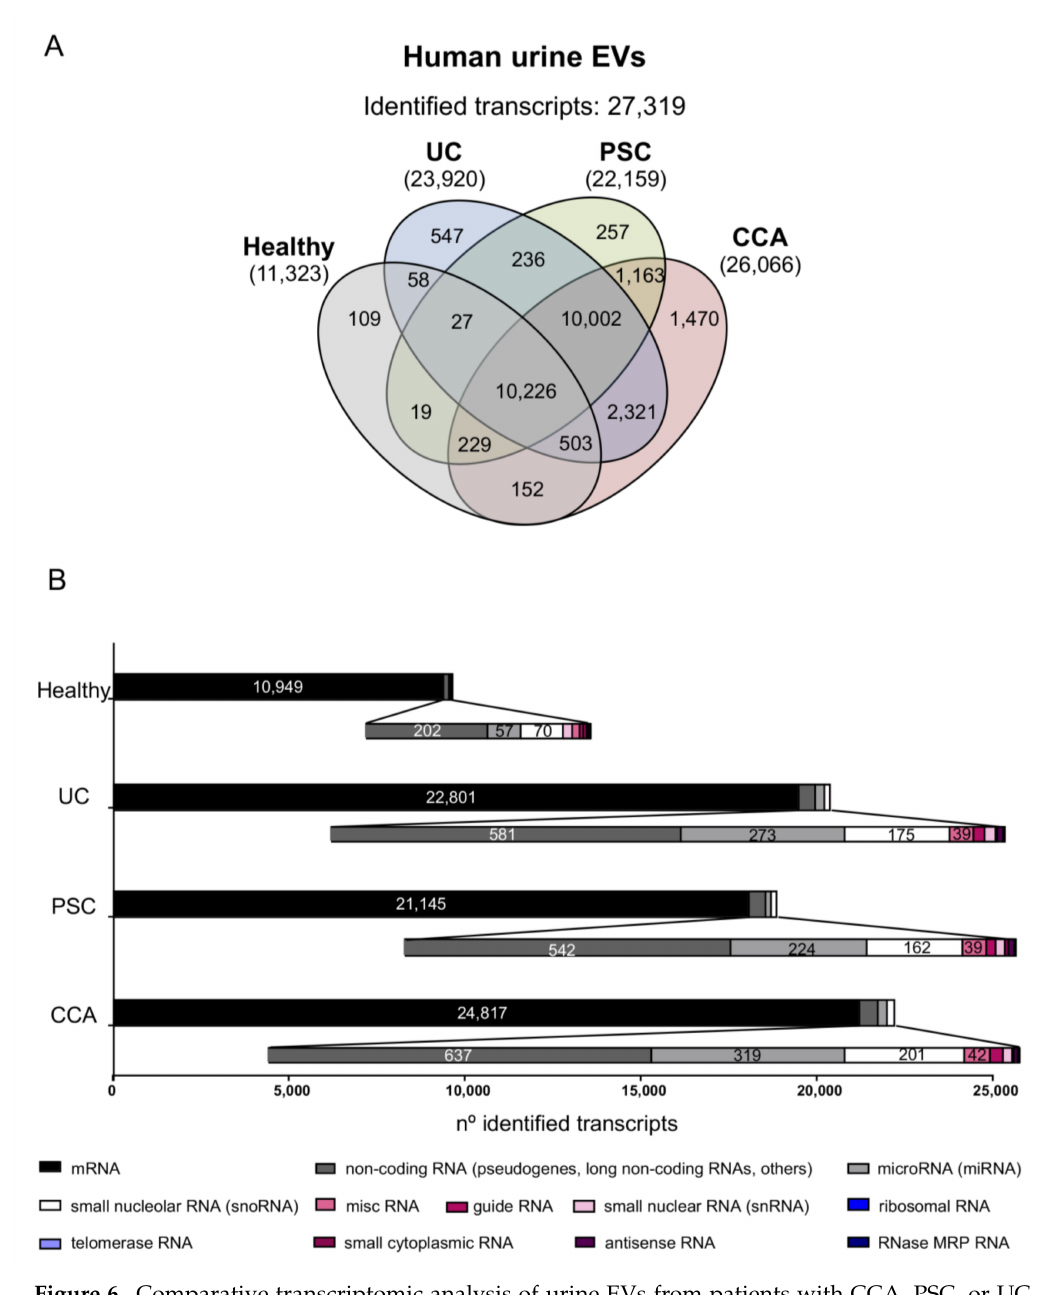
Figure 6. Comparative transcriptomic analysis of urine EVs from patients with CCA, PSC, or UC, and healthy individuals. ( A ) Venn diagrams showing the number of transcripts identified per group. Venn diagrams were generated using InteractiVenn web-based tool [29]. ( B ) Number of transcripts identified within each study group, subclassified according to their type [messenger RNA (mRNA), non-coding RNA (including mostly pseudogenes and long non-coding RNAs, among others), miscelaneous RNA (miscRNA), guide RNA, microRNA (miRNA), small nucleolar RNA (snoRNA), small nuclear RNA (snRNA), ribosomal RNA, telomerase RNA, small cytoplasmic RNA, antisense RNA and RNase MRP RNA]. In all groups, mRNAs constitute the most abundantly identified RNAs, followed by non-coding RNAs (pseudogenes, lncRNAs, and others), miRNAs, and